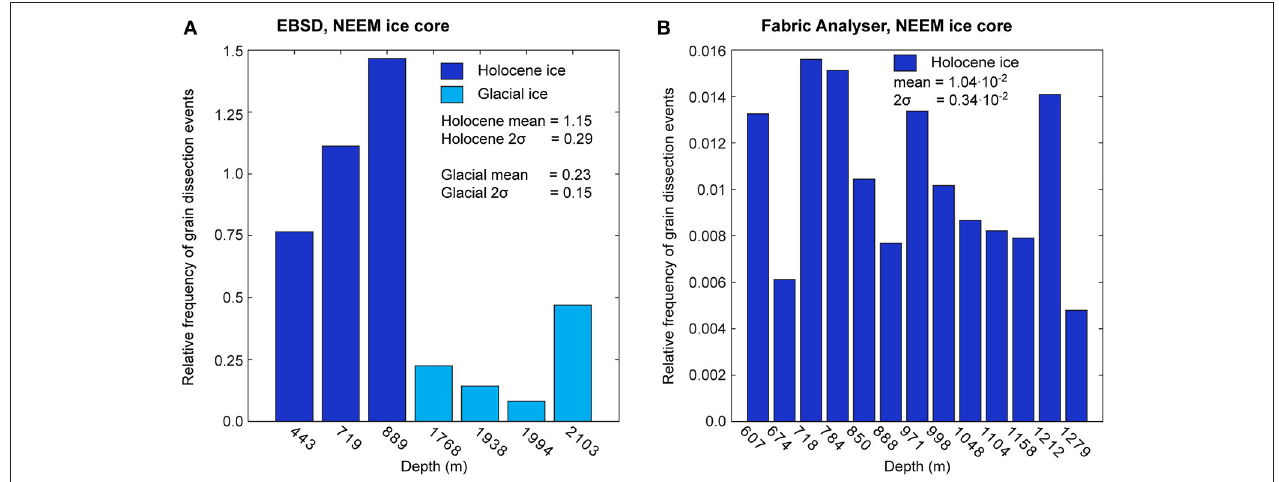
FIGURE 10 | Frequency of grain dissection events. (A) Results obtained from EBSD maps plotted as a function of depth across the transition from Holocene to glacial ice. (B) Results from c-axis maps (Fabric Analyser). The generally lower frequencies for c-axis maps are a result of only counting imminent grain dissection events in c-axis maps and completed dissection events in EBSD